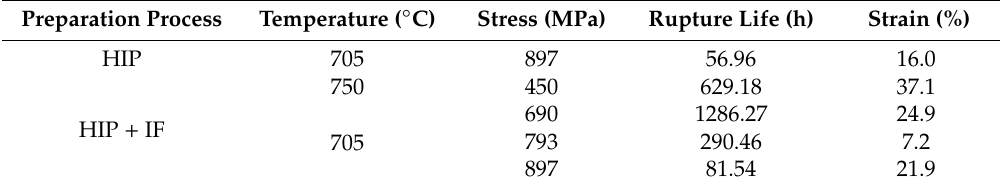
Table 2. The stress-rupture properties of FGH100L alloy under di ff erent